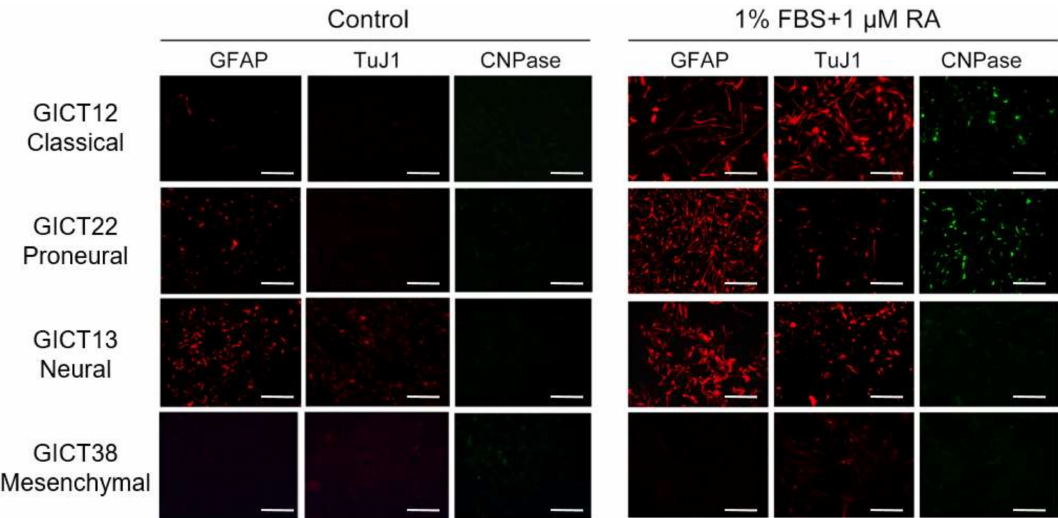
Figure 3. GIC subtypes cultured under di ff erent conditions (1% (fetal bovine serum) FBS + 1 µ M RA) exhibited varied potential for di ff erentiation into neural lineages. Most proneural and classical GICs displayed trilineage di ff erentiation potential, while neural GICs rarely di ff erentiated into the oligodendrocytic lineage. Mesenchymal GICs were less likely to di ff erentiate into astrocytic,